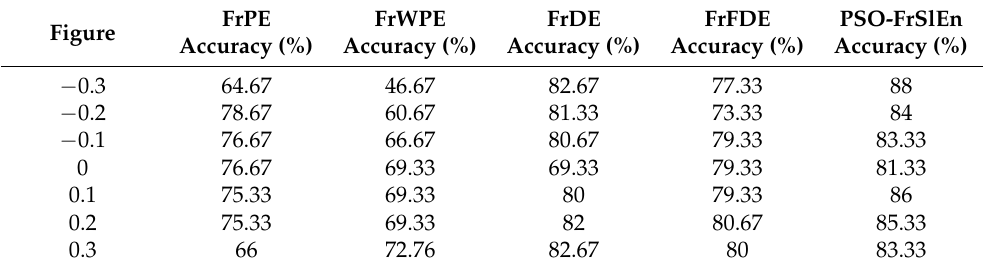
Table 1. The classification accuracy of each entropy under different fractional orders.